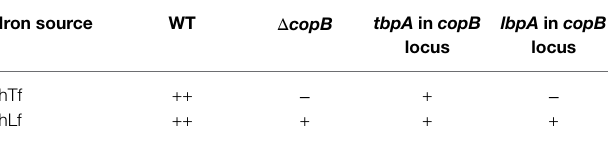
TABLE 4 | Growth phenotypes on exogenous hTf and hLf of strains generated by insertion of tbpA in copB locus of the Δ copB Δ tbpA mutant and insertion of lbpA in copB locus of the Δ copB Δ lbpA mutant.